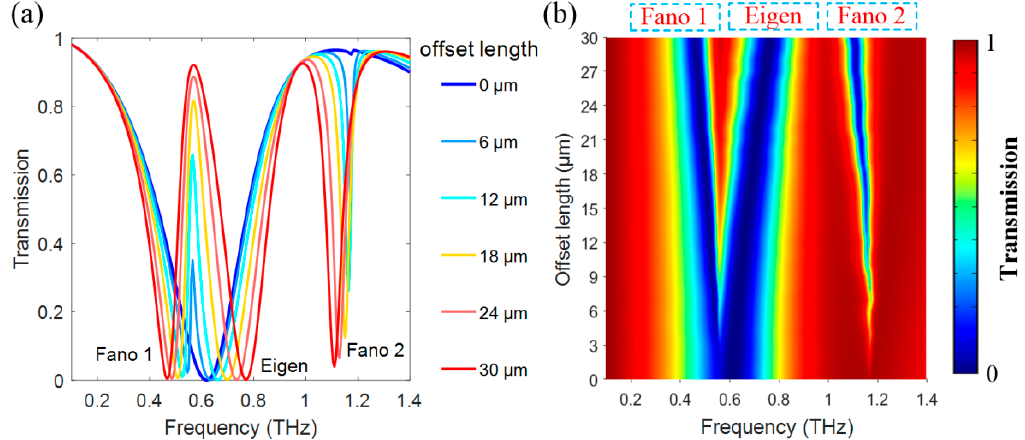
Figure 6. Transmission spectra of the VO 2 -implanted MM structures for different asymmetric Figure6. TransmissionspectraoftheVO 2 -implantedMMstructuresfordi ff erentasymmetricparameters parameters (offset length) at high temperature (70 °C): ( a ) one-and ( b ) two-dimensional graphs. (o ff set length) at high temperature (70 ◦ C): ( a ) one-and ( b ) two-dimensional